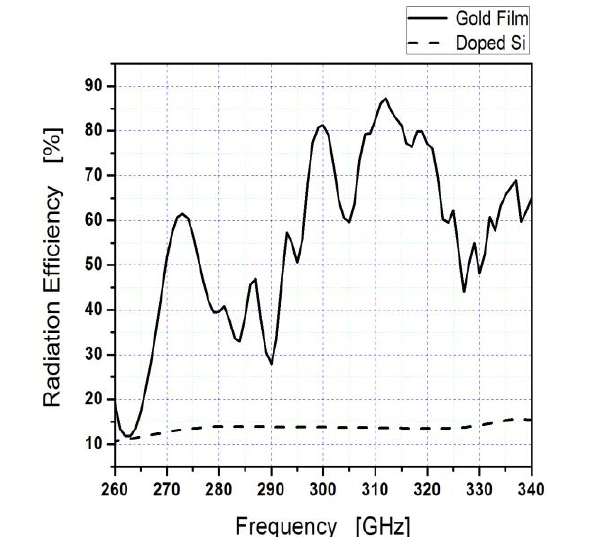
Figure 8: The radiation efficiency of the designed sinusoidally modulated leaky wave